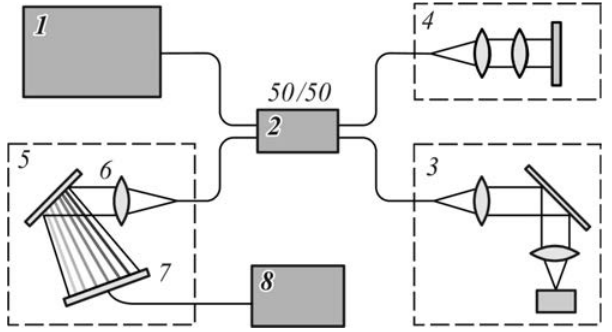
Fig. 3. Spectral domain OCT scheme: 1 (cid:1) broadband source, 2 (cid:1) 50/50 beamsplitter, 3 (cid:1) sample arm, 4 (cid:1) reference arm, 5- spectrometer with grating 6 and CCD camera 7, 8 (cid:1) com- puter with